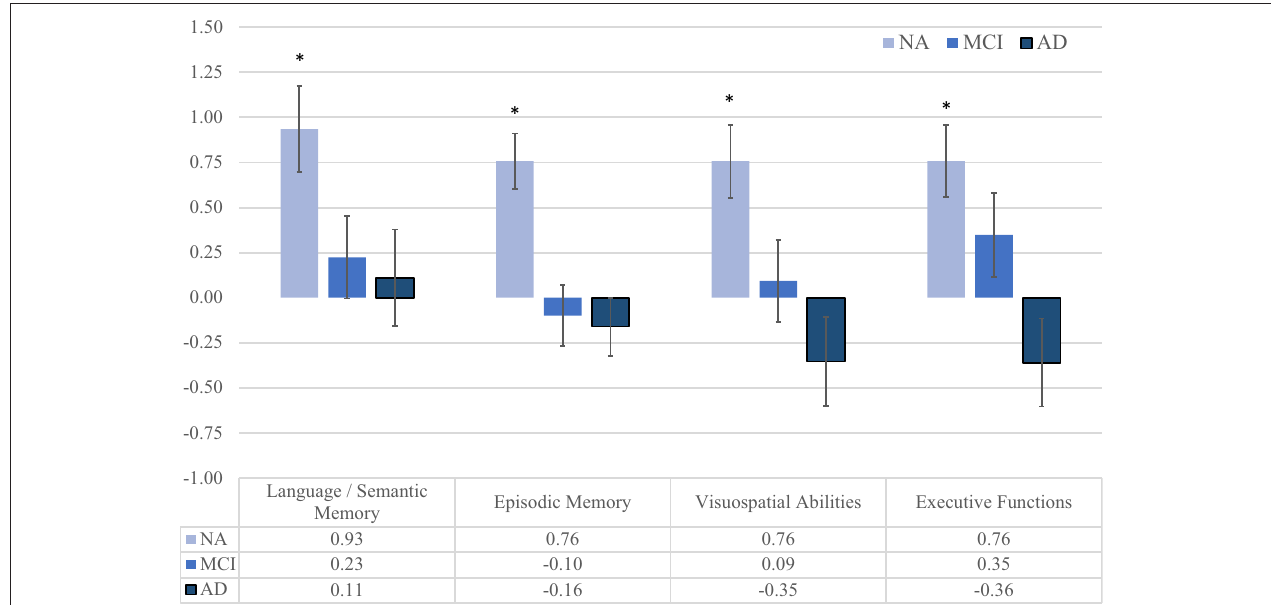
FIGURE 2 | Differences between the estimated marginal means (with age and education as covariates) on neuropsychological measures of depressed and non-depressed participants in each of the three groups. When we compared depressed and non-depressed participants in each group, we found significant differences only in NA participants. In this group, participants with clinically significant symptoms of depression showed lower performance in Executive Functions ( p < 0.001 , η p 2 = 0.37), Episodic Memory ( p < 0.001 , η p 2 = 0.21), Language/Semantic Memory ( p < 0.001 , η 2 p = 0.14), and Visuospatial Abilities ( p = 0.001 , η p 2 = 0.12). Effect sizes from MCI and AD patients ranged from * p < 0.01 to 0.03.